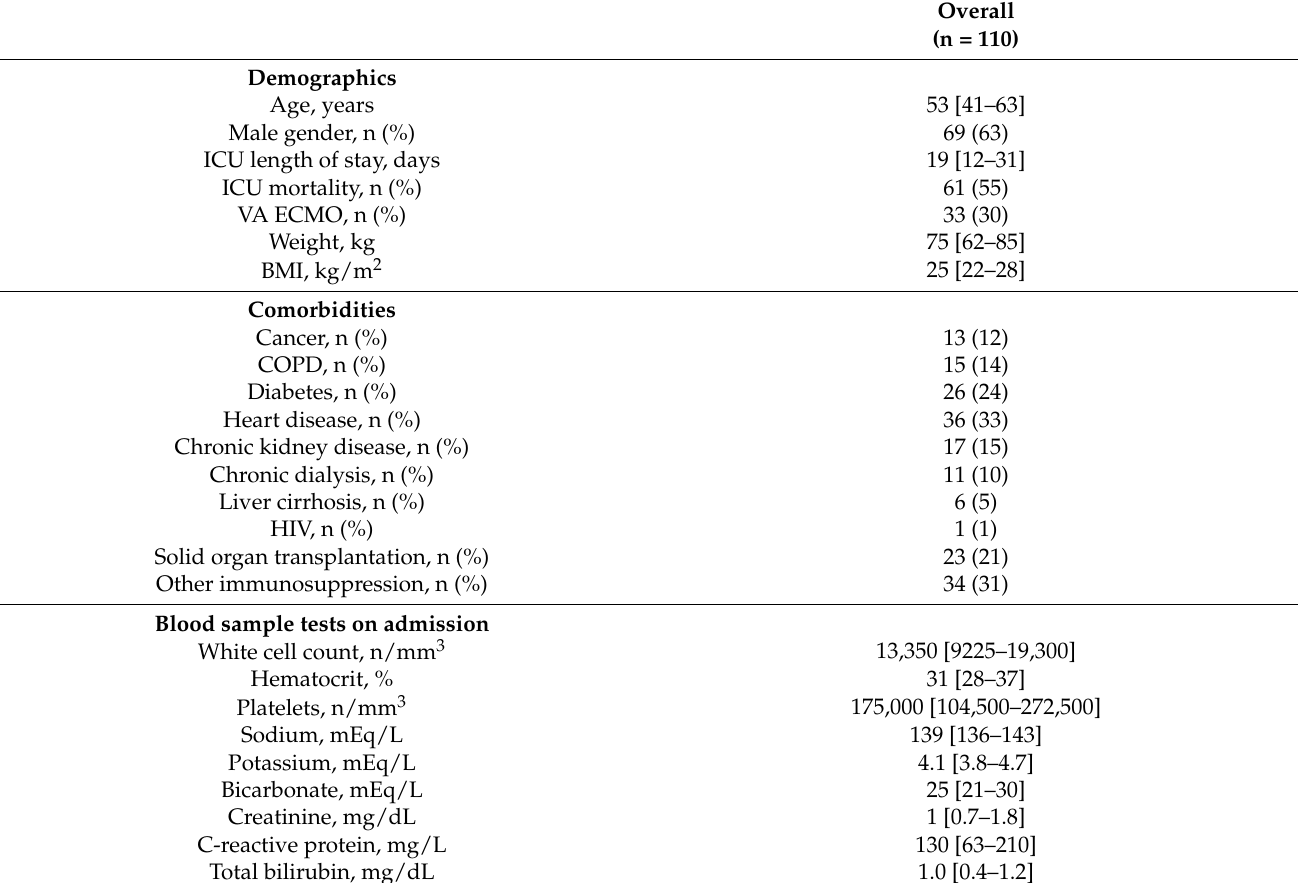
Table 2. Characteristics of the study population. Data are presented as count (%) or median (25th–75th percentiles). ICU = intensive care unit; VA = veno-arterial; ECMO = extra-corporeal membranous oxygenation; BMI = body mass index; COPD = chronic obstructive pulmonary disease; HIV = human immunodeficiency virus; PaO 2 = partial pressure of oxygen; PaCO 2 = partial pressure of carbon dioxide; FiO 2 = fraction of inspired oxygen; APACHEII = Acute Physiology and Chronic Health